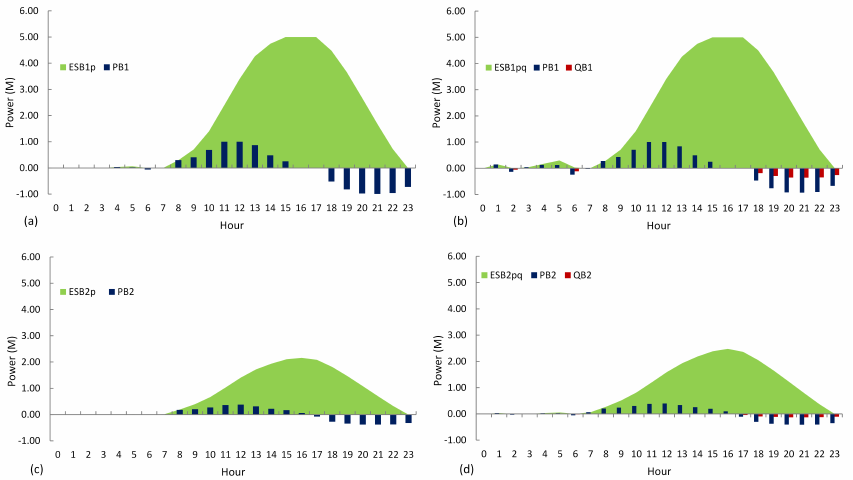
Figure 8. Power management for two BESS units: ( a ) active power BESS 1; ( b ) active and reactive power BESS 1; ( c ) active power BESS 2; ( d ) active and reactive power BESS 2.